Question: Briefly state, in one sentence, what is plotted here.
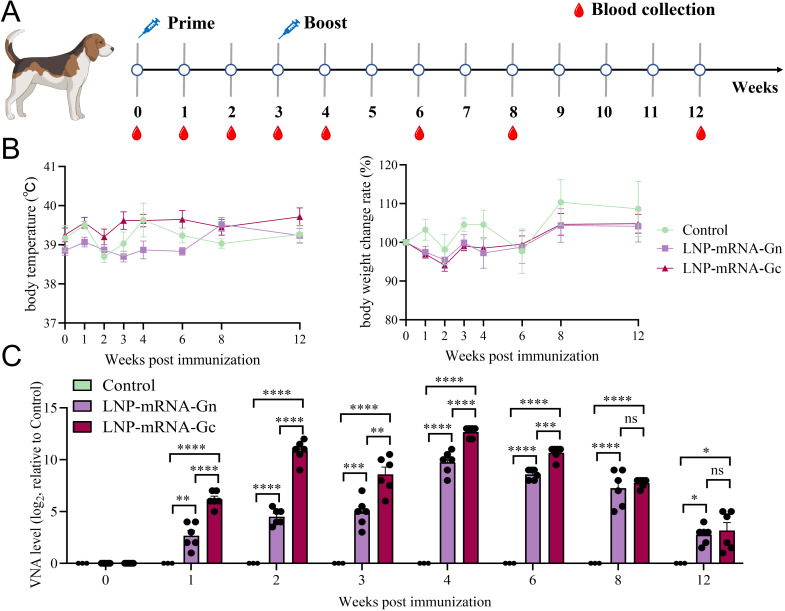
Answer: Efficacy of mRNA vaccines in dogs. ( A ) Schematic diagram of the immunization procedure for the dogs and the blood collection time point. ( B ) Body temperatures and weights of the dogs were recorded at the time of each blood sample collection. ( C ) The specific VNAs from dog blood samples against SFTSV were detected at 0, 1, 2, 3, 4, 6, 8, and 12 weeks postimmunization (control group [ n = 3]; LNP-mRNA-Gn group [ n = 6]; LNP-mRNA-Gc group [ n = 6]; values are means ± SEM; ANOVA with Tukey’s multiple comparisons test). * P < 0.05, ** P < 0.01, *** P < 0.001, **** P < 0.0001; ns, not statistically significant.